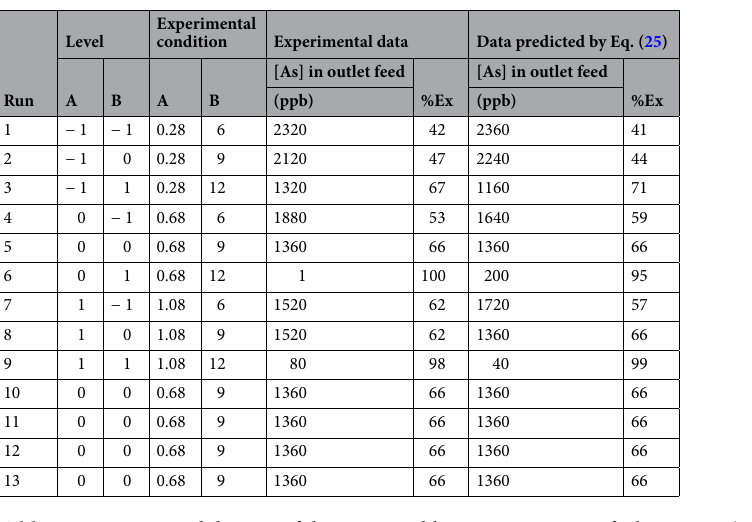
Table 3. Experimental designs of the two variables: concentration of Aliquat 336 (A) and pH of feed solution (B) having 3 levels (− 1, 0 and 1); initial concentration of arsenic ions in the inlet feed solution = 4000